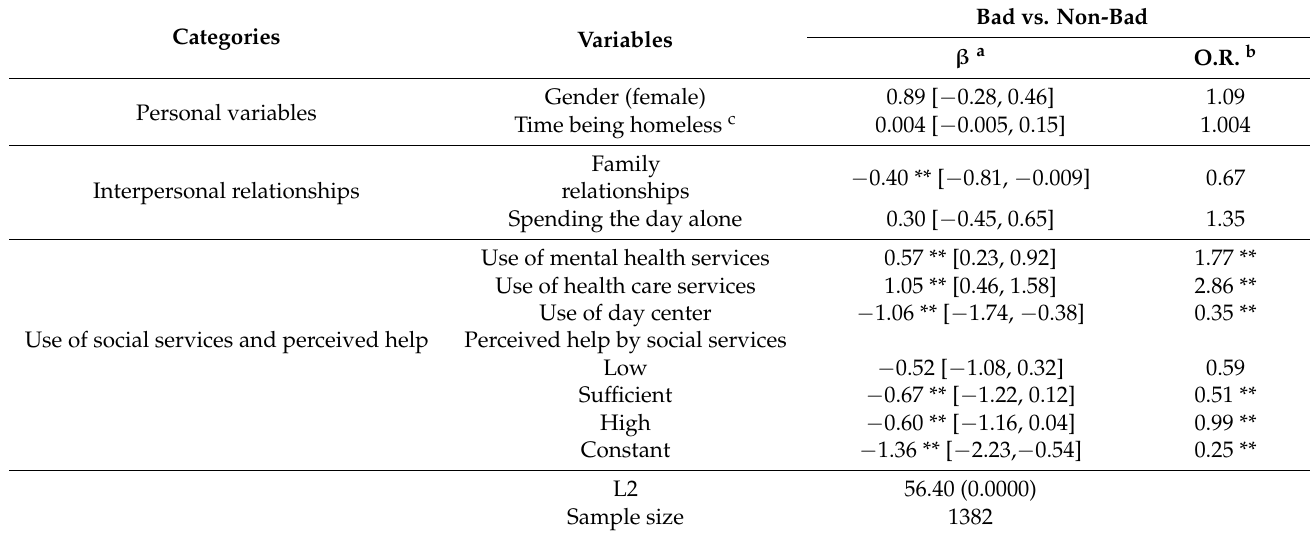
Table A1. Impact of some variables on a bad self-perceived health status (binary